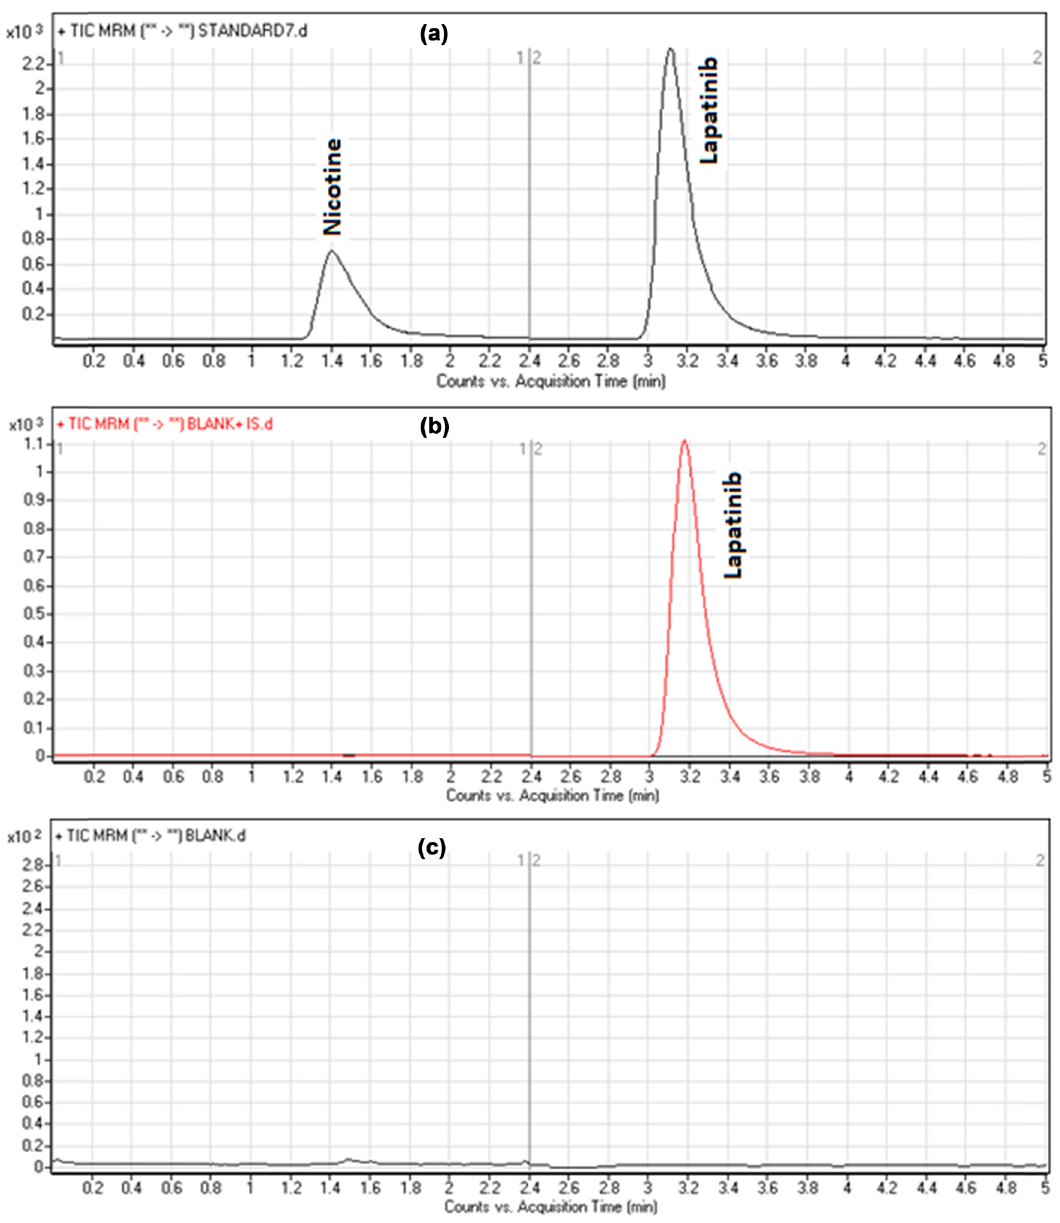
Figure 2: Total ion chromatogram MRM chromatograms of ( a ) NT and lapatinib ( IS ) , ( b ) blank with IS and ( c ) double blank ( without NT and IS )